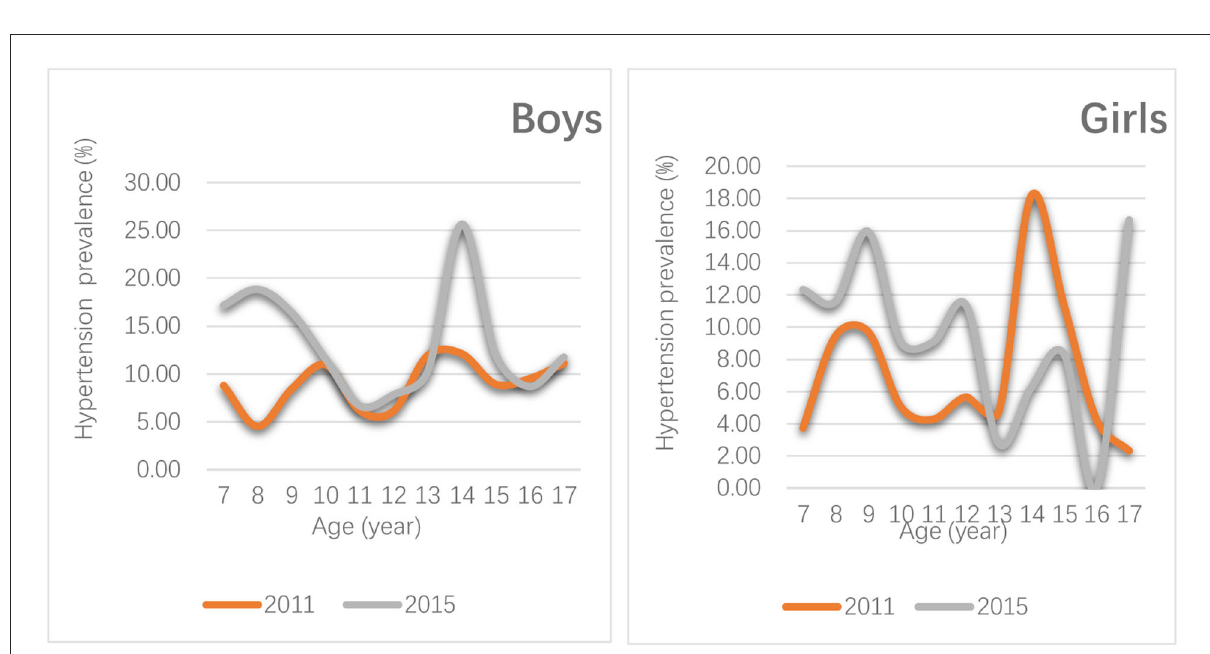
FIGURE3 Distribution change of the prevalence of hypertension in boys and girls aged 7–17 years in China,